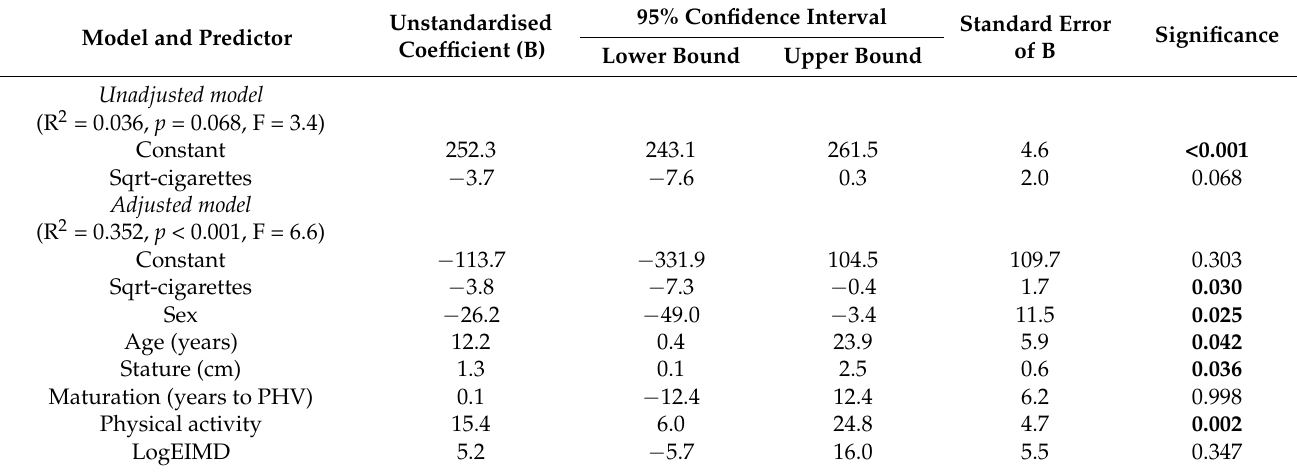
Significance of B